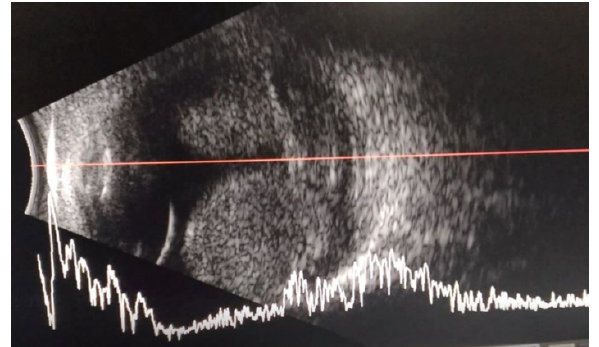
Figure 1: Photomicrograph of the ocular ultrasound of the right eye